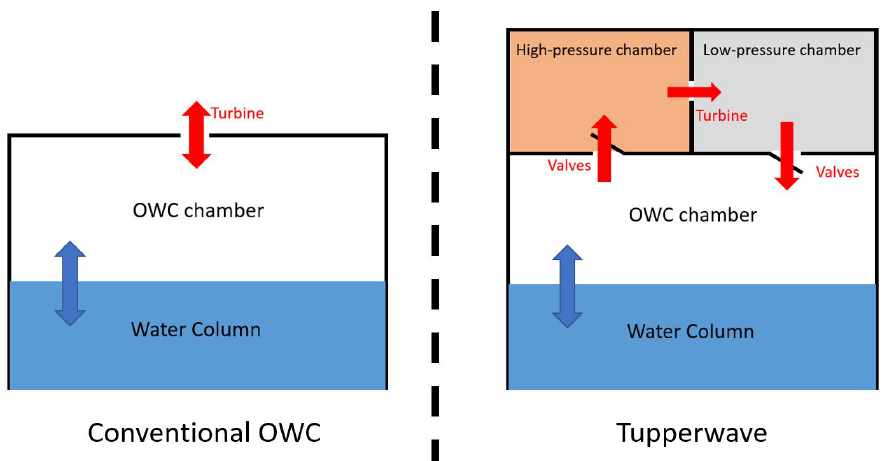
Figure 1. Schematic diagram of the conventional Oscillating-Water-Column (OWC) and Tupperwave device